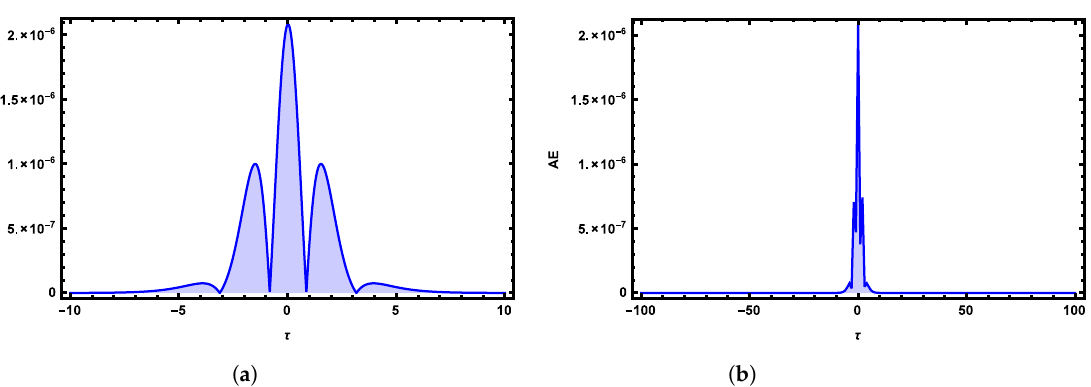
Figure 18. Plots of ( a ) the exact solution and ( b ) FNAM solution at k = 1, τ ∈ [ − 10,10 ] and ξ ∈ [ 0,1 ] for Example 4.